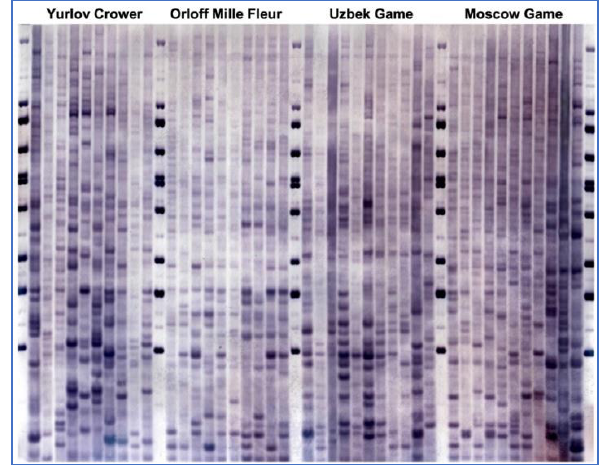
Figure 1. Exemplary multilocus DNA fingerprinting filter generated for within- and between-breed biodiversity evaluation using anonymous RFLP markers in four chicken breeds. DNA fragments resulted from restriction with Hae III (or Bsu RI), followed by probing with digoxigenin-labelled oligonucleotide (GTG)5. Lanes 1, 12, 23, 35, and 47: DNA ladder (see details in the Section 2.2).